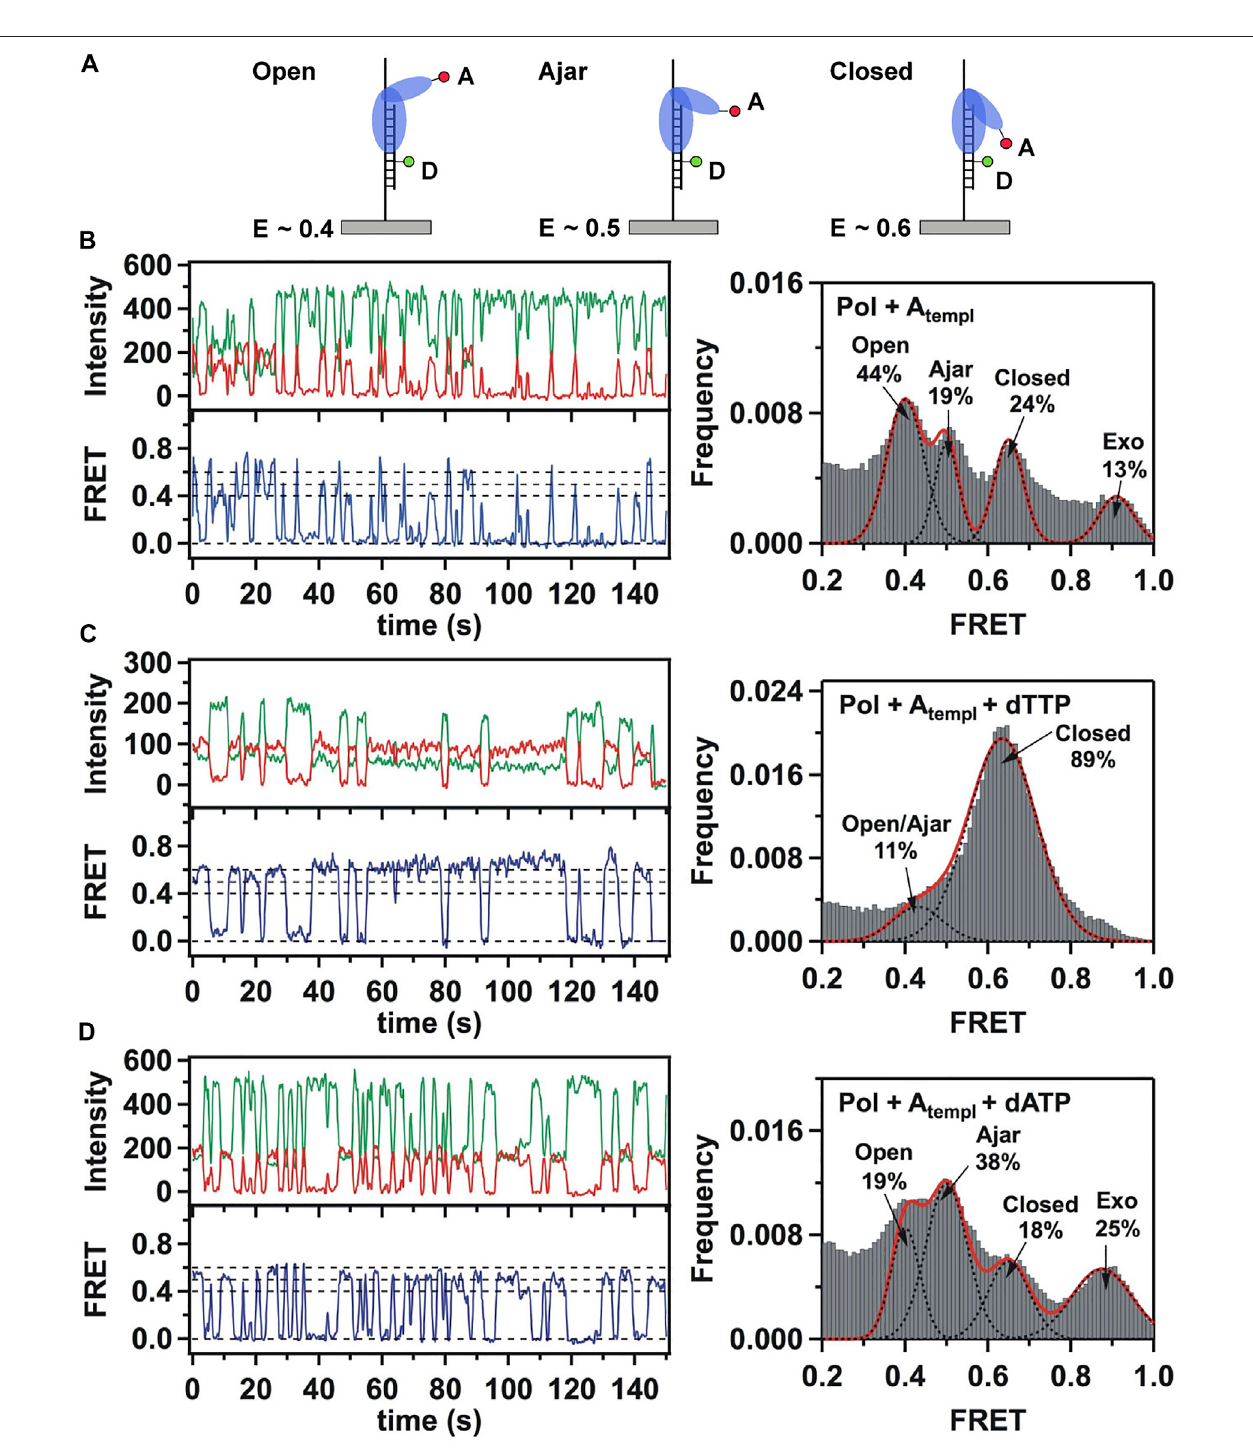
FIGURE 2 | Single-molecule FRET analysis of the fi ngers closure transition in KF. (A) Schematic illustration of the three FRET states associated with different conformations of the fi ngers domain, with the observed FRET ef fi ciencies indicated. (B) smFRET data in the absence of nucleotide substrates. Representative donor intensity (green), acceptor intensity (red) and corresponding FRET ef fi ciency (blue) trajectories are shown on left. The perfect anticorrelation of the donor and acceptor intensity fl uctuations is proof that FRET is occurring. The dashed horizontal lines superimposed on the FRET trajectory indicate the FRET ef fi ciencies of the open ( E = 0.4), ajar ( E = 0.5) and closed ( E = 0.6) states. Histogram of FRET ef fi ciencies compiled from multiple traces and fi t to four distinct states is shown at right. (C) In the presence of the correct dTTP substrate. (D) In the presence of the incorrect dATP substrate. Reproduced from reference (Berezhna et al., 2012) with permission.